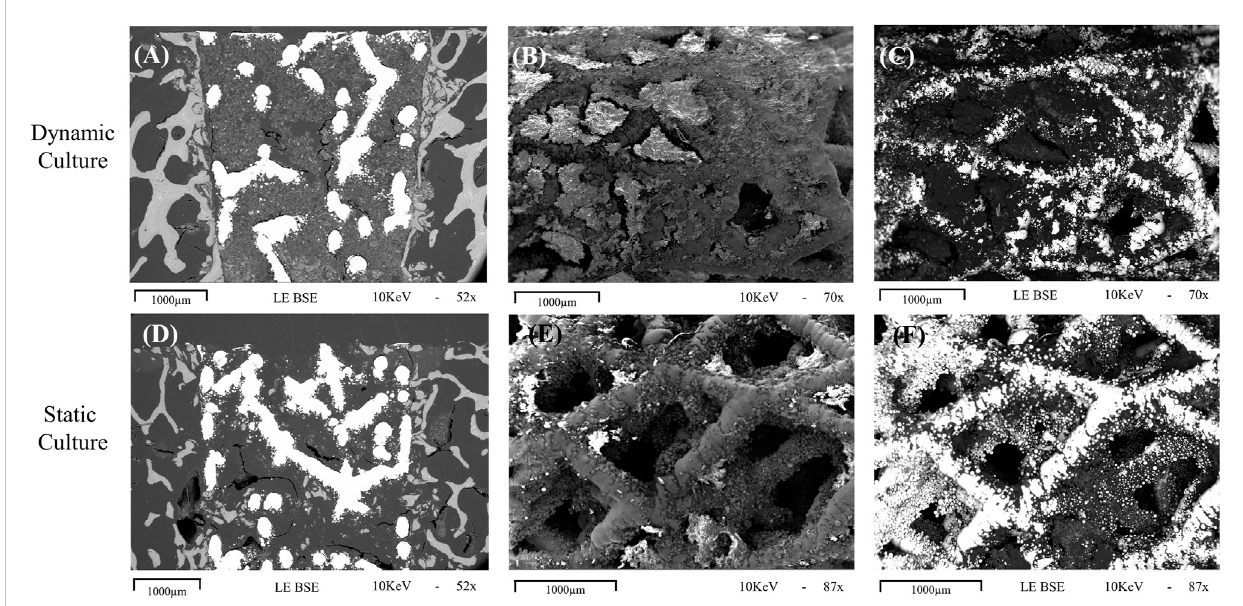
FIGURE 5 Representative images obtained with scanning electron microscopy for dynamic (top row, (A-C) and static (bottom row, D-F ) cultures (A, D) Cross sections of the implant in situ , taken with the BSE technique showing evidence of mineralisation within the implant pores, with more seen in the sample taken from dynamic culture. (B, C) macroscopic images taken with standard and BSE methods, respectively, showing the outer cylindrical surface of an explanted implant with abundant tissue formation on the surface and within the pores. (E, F) standard and BSE images of the outer surface of an explanted statically cultured implant also showing tissue formation on the surface, albeit less than that seen for the dynamic culture. 1000 μ m scalebars are shown.